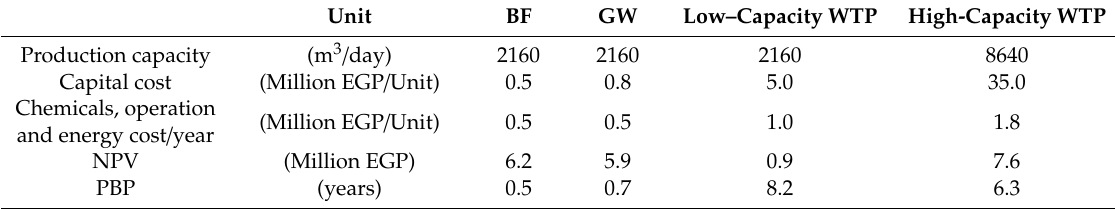
Table 4. Economic comparison between current treatment techniques and BF in Aswan City,